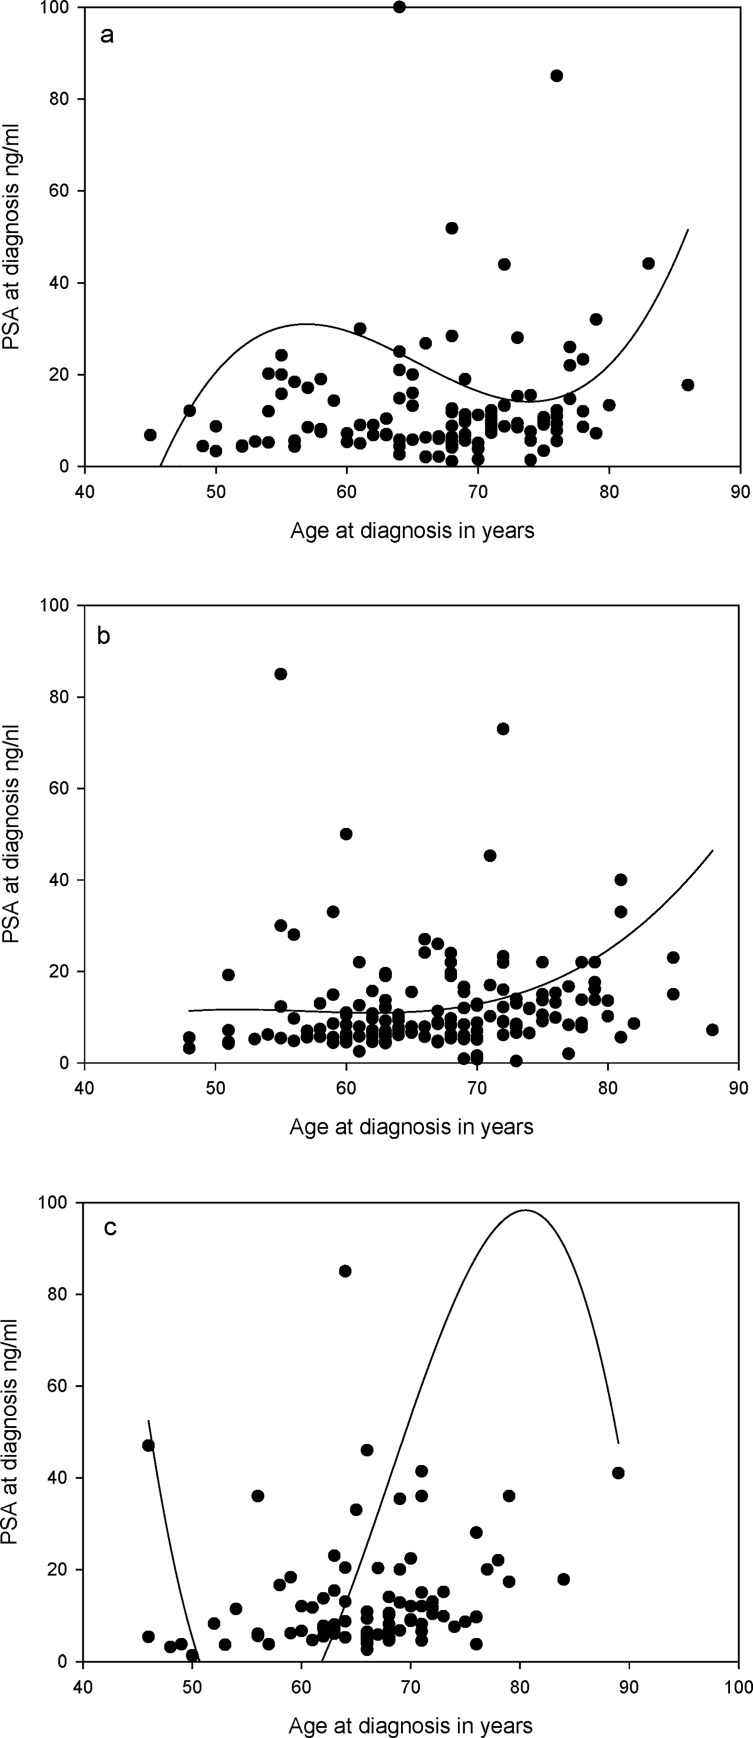
Trend lines between age and PSA at diagnosis for the AKR1C3 rs12529 genotypes in the main cohort.(a—CC genotype, b—CG genotype and c—GG genotype).